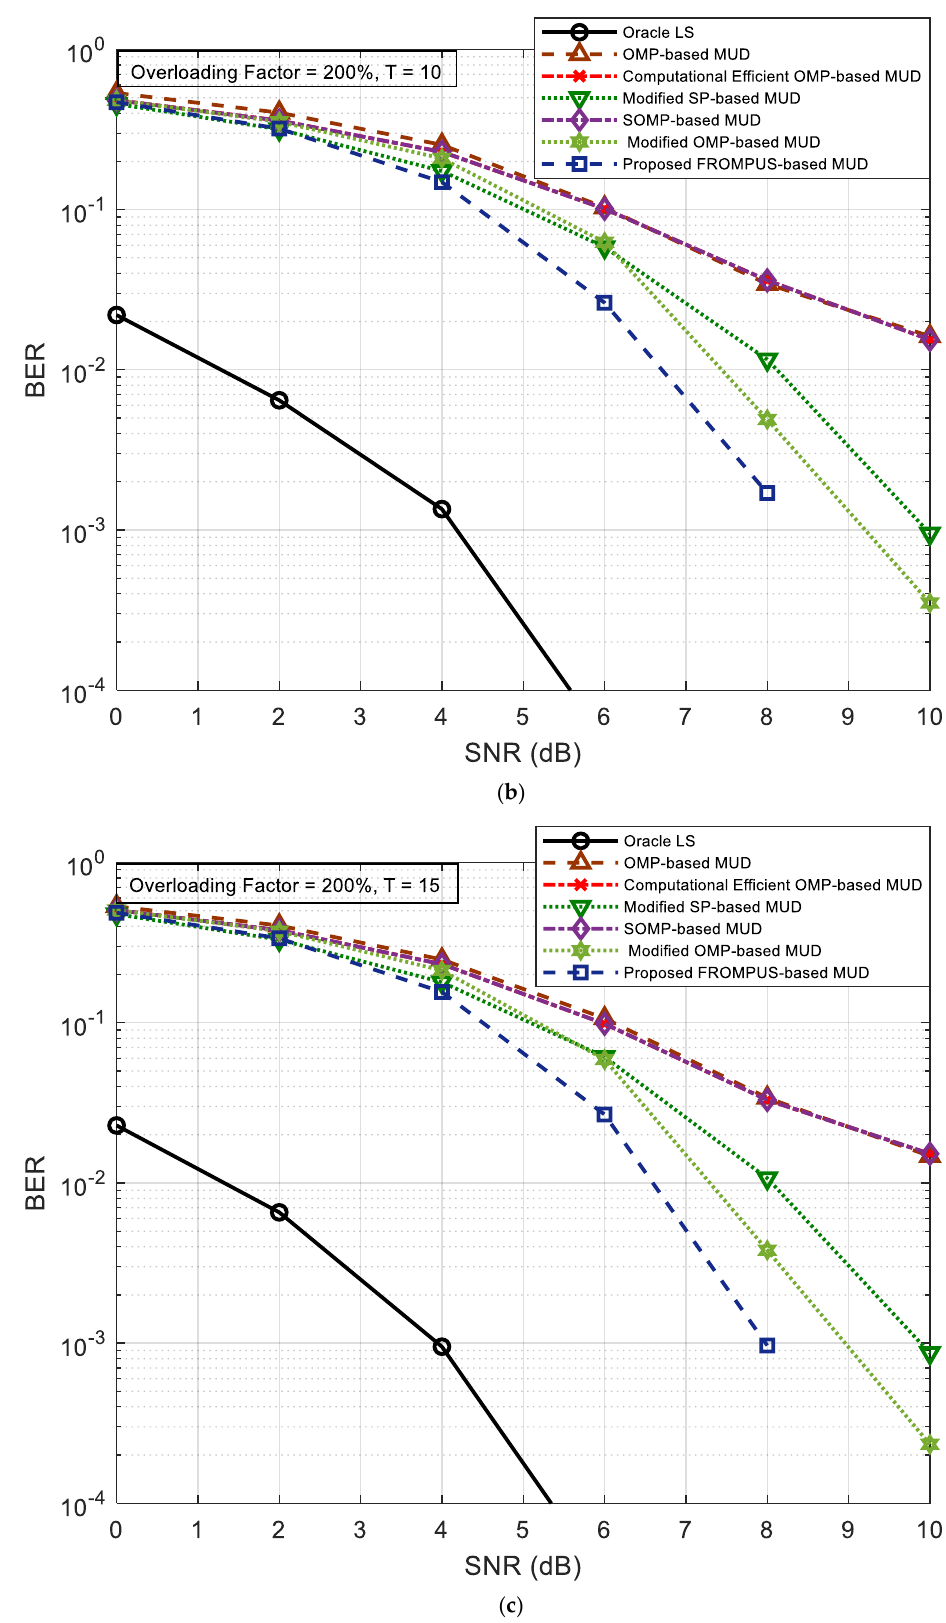
Figure 6. Achievable BER versus SNR performance of the FROMPUS-based MUD in comparison with five other MUDs, overloading factor= 200%, ℑ = 20 : ( a ) 𝑇 = 5 ; ( b ) 𝑇 = 10 ; ( c ) 𝑇 = 15 .